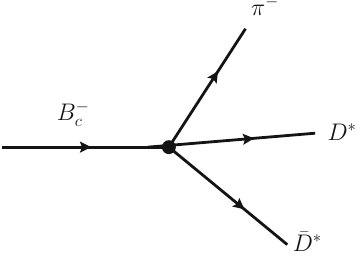
Fig. 3 Mechanism to produce the J /ψω final state through rescatter- ingofthe D ∗ ¯ D ∗ and D ∗ s ¯ D ∗ s components. R iseitherthe X ( 3922 )( 2 ++ ) or X ( 3943 )( 0 ++ )